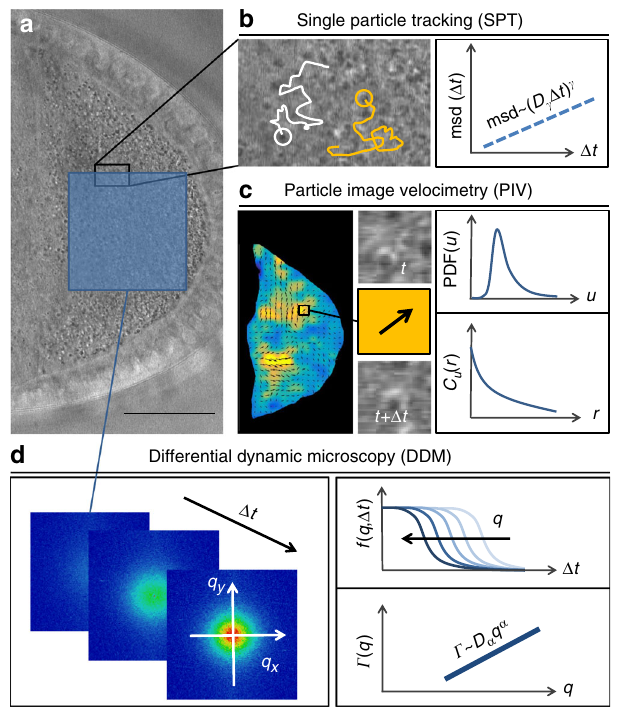
Fig. 5 Experimental approaches to quantify intracellular motion. a Representative st9 oocyte imaged by DIC microscopy. Scale bar is 30 µ m. b SPT relies on the identi fi cation of speci fi c particles in each time frame, and linking their position across different frames to reconstruct a trajectory (left panel). The typical output of SPT analysis is the mean squared displacement (MSD). The exponent γ , characterizing the dependence of the MSD on the delay time Δ t in a given regime, indicates the nature of motion (e.g., diffusive, superdiffusive), while the prefactor D γ represents a generalized diffusion coef fi cient. c PIV enables the reconstruction of a coarse-grained velocity map, where a 2D vector u , representing the local velocity, is associated to each point on a regular grid (left panel). u is determined by estimating the average net displacement across two time frames ( δ t ) of the particles comprised within a small window (middle panels). PIV analysis allows the characterization of the statistical properties of fl ows associated with the ballistic motion of the tracer particles, for example the probability distribution function PDF( u ) of speeds or the spatial velocity correlation function C u ( r ) (right panel). d Compared to SPT and PIV, DDM is not based on direct-space analysis. Instead, DDM quanti fi es the dynamics in the Fourier space, measuring the relaxation of spontaneous density fl uctuations occurring at different wave vectors q (left panel). This relaxation process is captured by the intermediate scattering functions f ( q , Δ t ), represented on semi-logarithmic scales for various values of q . The behavior as a function q of the characteristic relaxation rate Γ associated with the decay of f ( q , Δ t ) provides a key information about the nature of the motion and allows to determine the relevant parameters. The lower left panel represents the simple and important case where Γ has a power-law dependence on q (log – log scale). This occurs, for example, when the underlying dynamic is diffusive ( α = 2 and D α is the diffusivity) or ballistic ( α = 1 and D α coincides with a characteristic